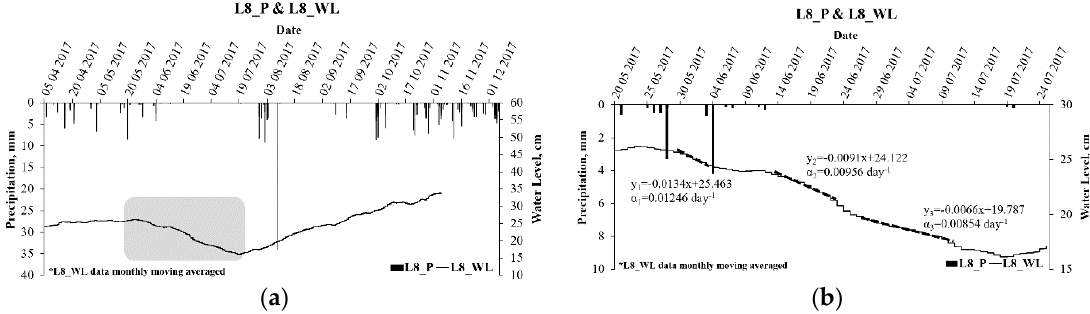
Figure 12. ( a ) The period (grey area) where the recession coefficients for the L8_WL data were calculated in; ( b ) three different recession coefficients were calculated for L8_WL data.